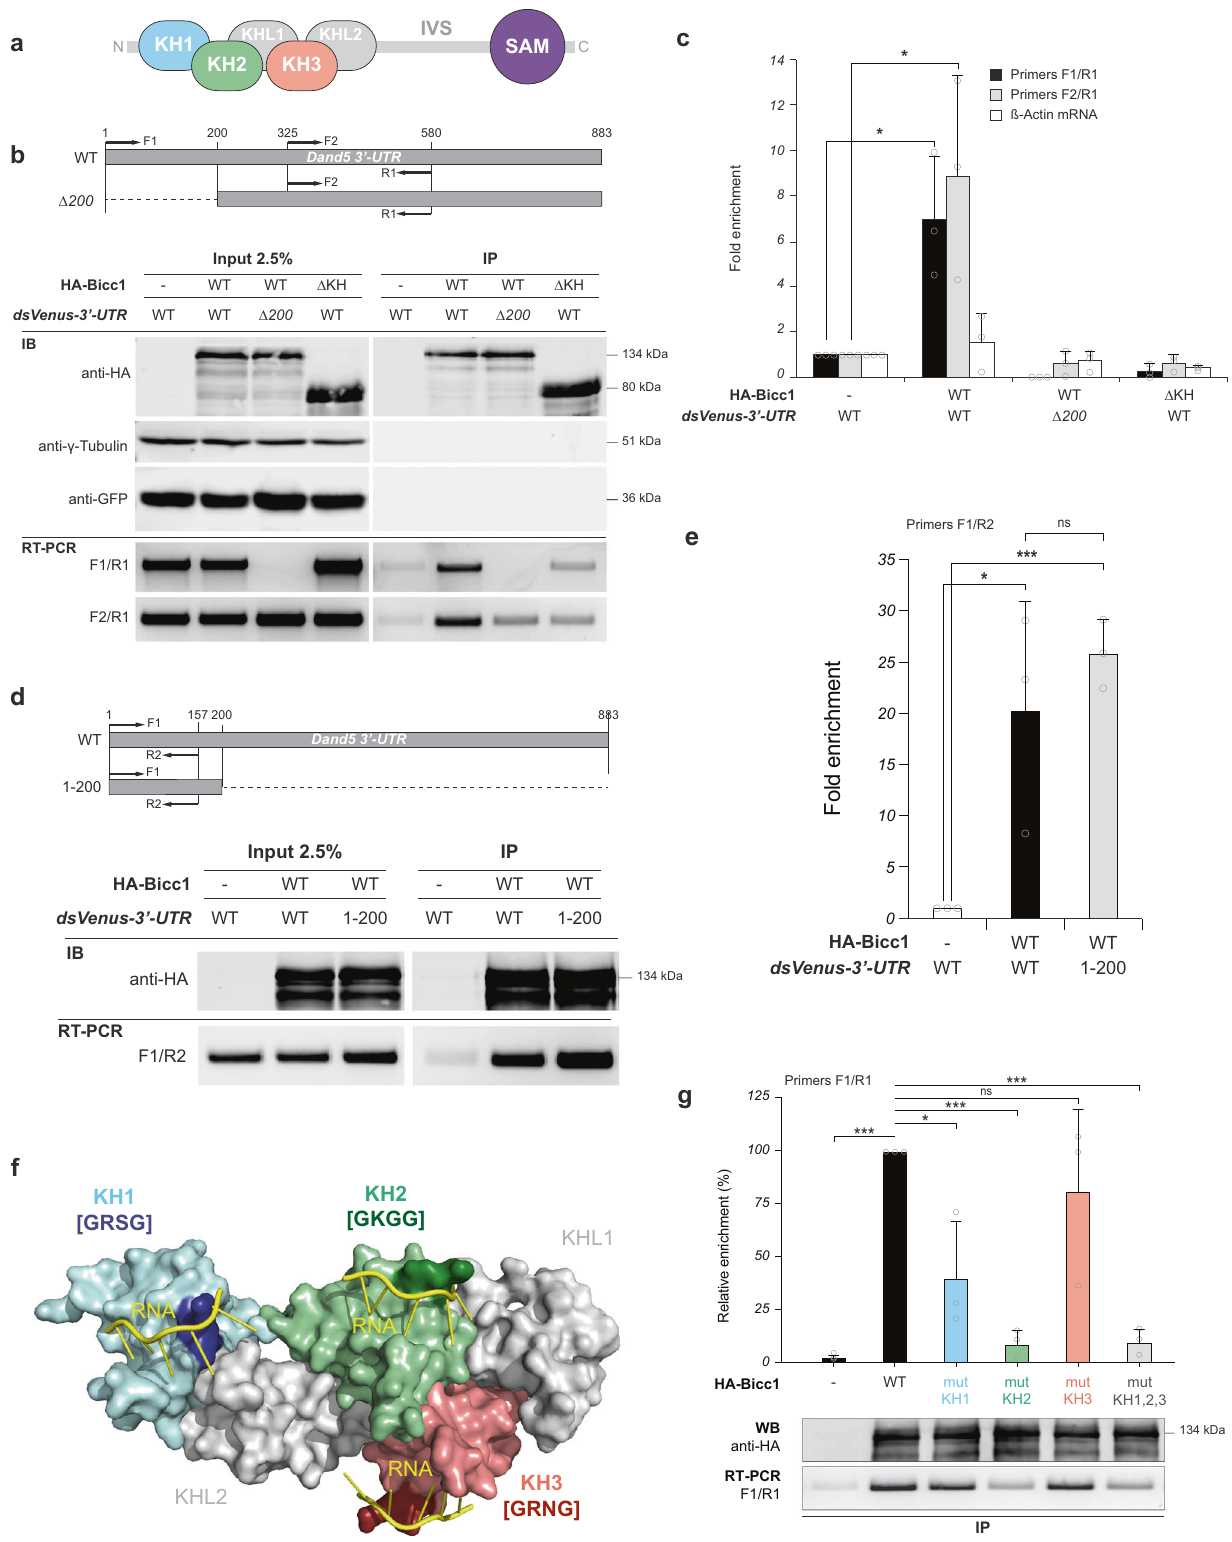
observed between these two mutants in their af fi nity for Bicc1, suggesting that speci fi c Bicc1 binding depends on the GACGU- GAC sequence and not just on the secondary structure (Fig. 7b, bottom panels). As another independent speci fi city control, we used the GACGUGAC octamer to replace a similar, though non- speci fi c, GCCCUGGG sequence after two adenosines in the